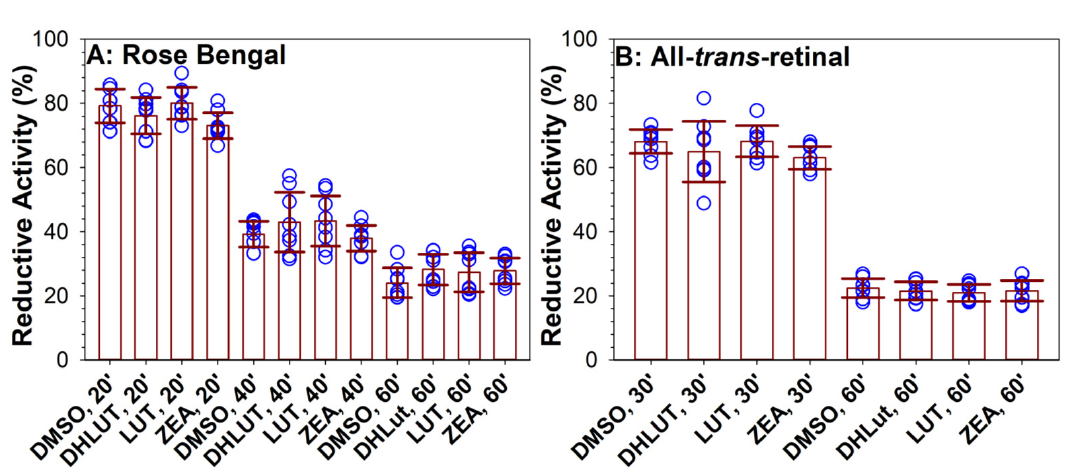
Figure 7. Supplementation with carotenoids for 19 days does not affect reductive activity of cells following damage induced by photosensitizers and light. Reductive activities of cells after 19 days of supplementation with vehicle (DMSO) or carotenoids: dehydrolutein (DHLut), lutein (LUT), and zeaxanthin (ZEA) measured by MTT assay immediately after 20, 40, or 60 min exposure to visible light (0.46 mW/cm 2 ) and 0.5 µ M rose bengal (A) or 24 h after 30 or 60 min exposure to visible light and liposomes containing 0.5 mM all- trans -retinal and 2.8 mg/mL EYPC (B). The reductive activities are expressed as ratios of reductive activity of cells in the presence of the photosensitizer to reductive activity of cells exposed to the same treatment in the absence of the photosensitizer. The symbols indicate individual measurements, the heights of the bars indicate the means, and the error bars indicate SDs. There were no statistically significant differences between DMSO and carotenoid-supplemented cells under each duration of exposure to light and rose bengal or all- trans -retinal.